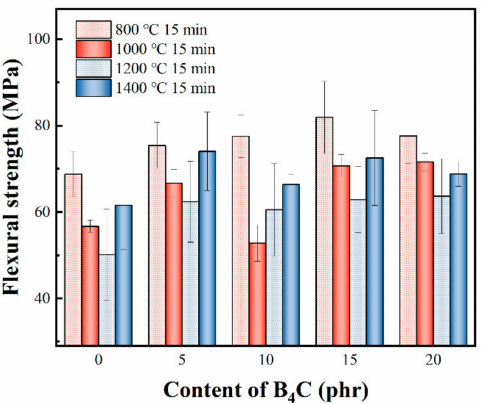
Figure 4. Flexural strength of composites with different contents of B 4 C after treatment at differ- ent temperatures.